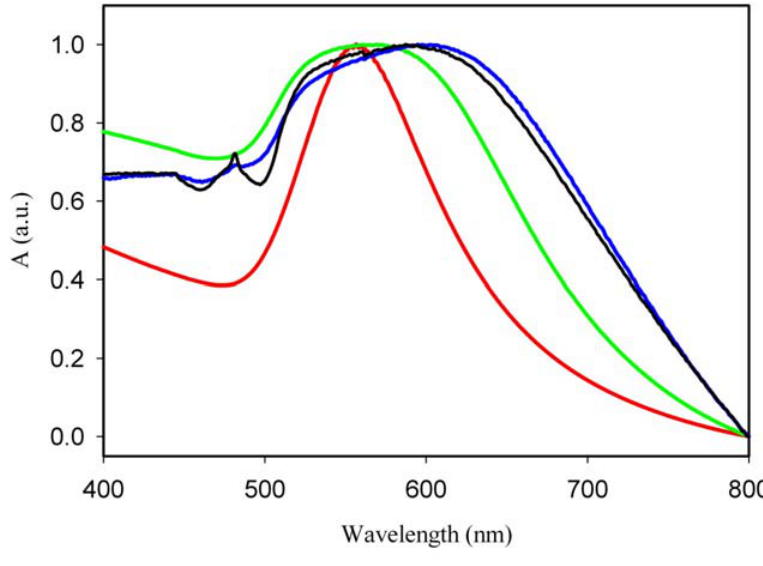
Figure 12. Sensing experiment performed on the annealed sample. Red curve: LSPR gold band in the annealed nanocomposite, green curve: after immersion in ethanol solution of 1-octadecane thiol, blue curve: after immersion in the antibody solution, and black curve: after immersion in the antigen